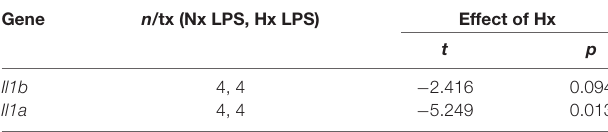
TABLE 6 | Paired- t -test results for Hx priming 6 days post-Hx.